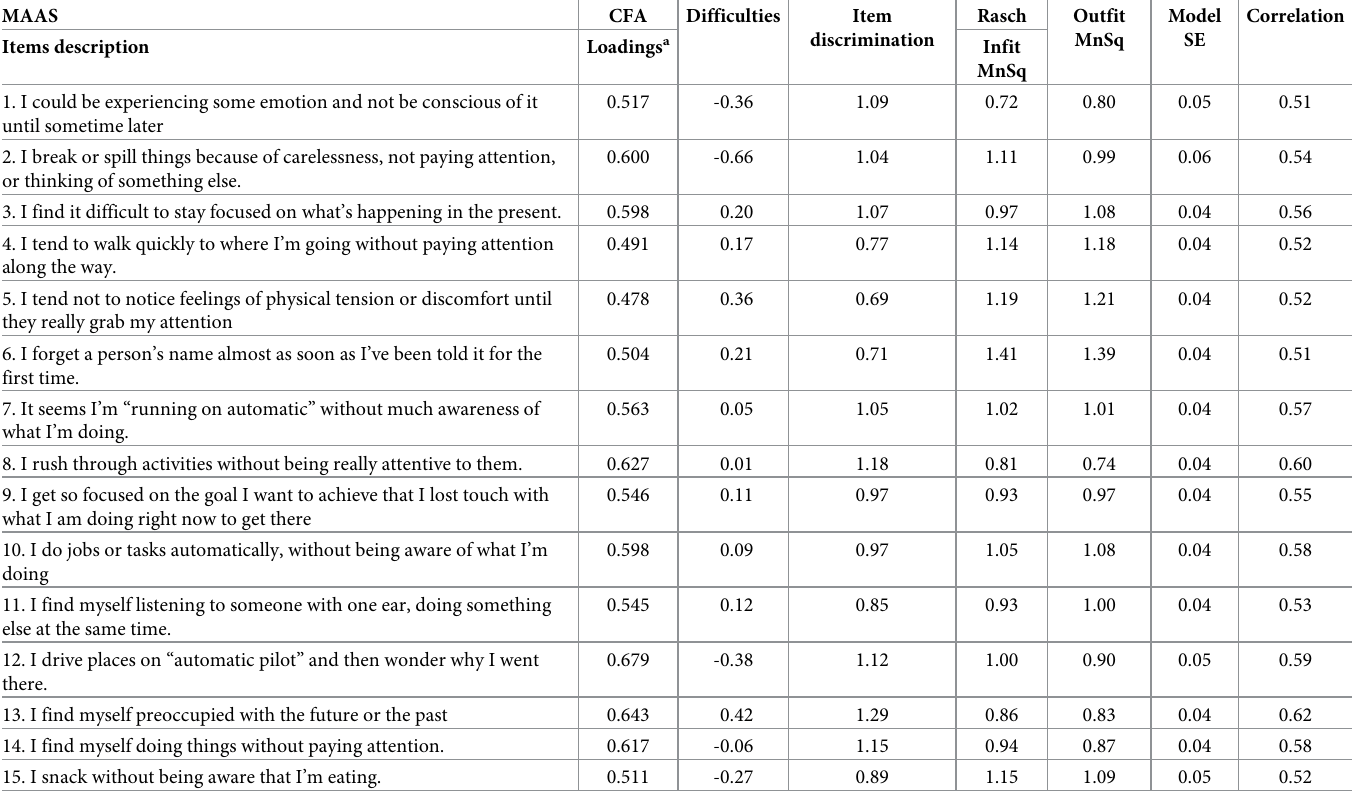
Table 3. Standardized factor loadings in confirmatory factor analysis (CFA) and Rasch difficulties and fit statistics for each item. MAAS